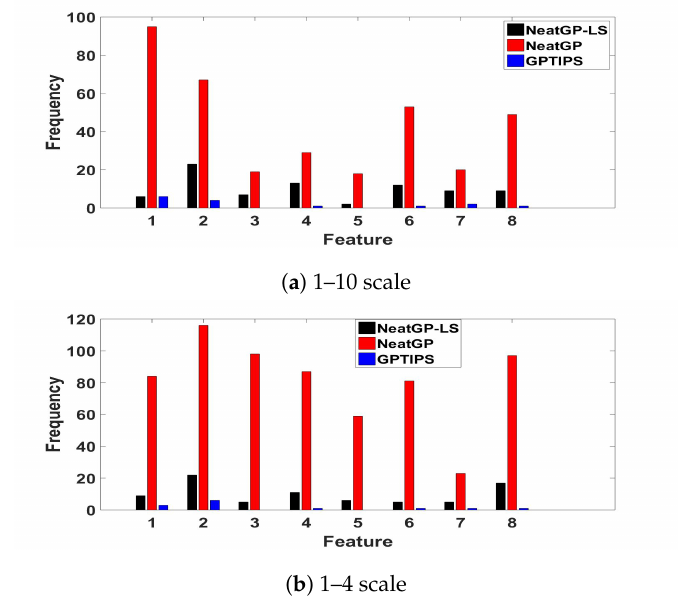
Figure 6. Frequency of appearance of each DE (feature variables x 1 to x 8 ) in the best solutions found by each method on the